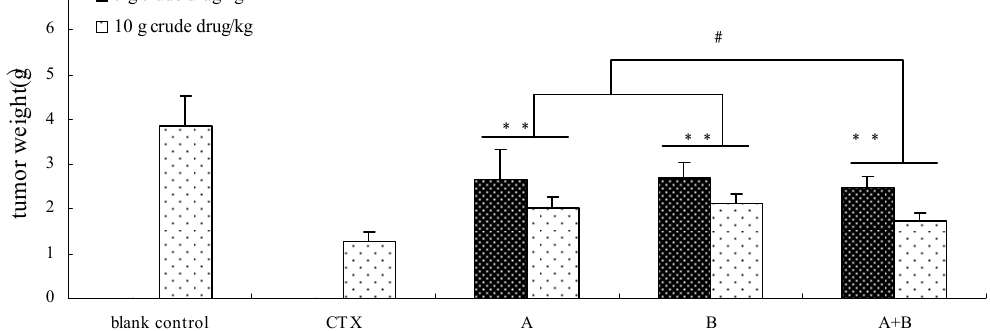
Figure 8. Effect of components and components combination on tumor weight of mices.